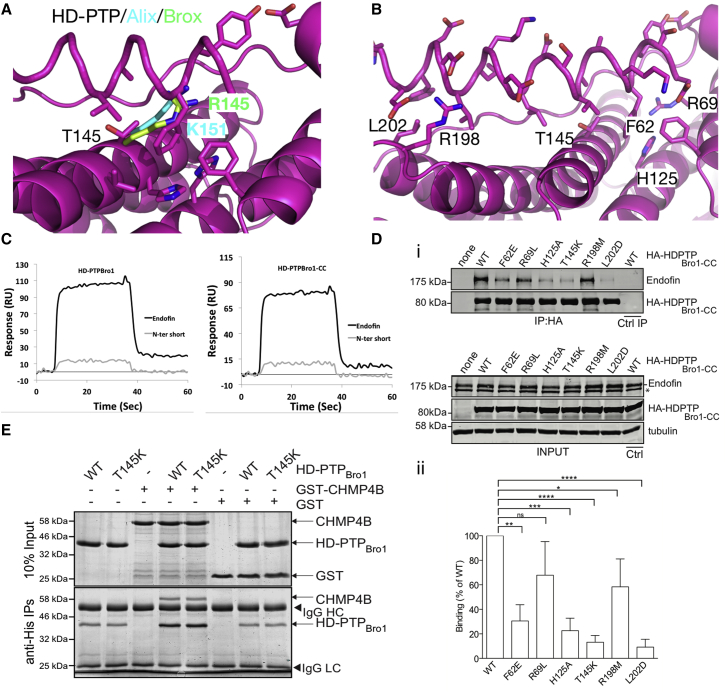
Mapping the Interface at the S Site(A) Detail at the S site of HD-PTPBro1-endofin complex showing the position of T145, a key residue at the binding interface. The cognate residues on the related Bro1 proteins (K151 in Alix in cyan; R145 in Brox in green) are larger and clearly would clash with the endofin peptide, explaining the binding selectivity observed.(B) Detail of the HD-PTPBro1-endofin binding interface showing the position of the residues used in the mutagenesis evaluation, labeled black.(C) Biosensor binding studies confirmed the importance of the conserved MXXYF region at the N terminus of the SARA and endofin peptides. An endofin peptide lacking these residues shows poor binding to HD-PTPBro1 and HD-PTPBro1-CC as shown in contrast to the wild-type endofin peptide.(D) HA-HD-PTPBro1-CC or the indicated mutants were expressed in cells and anti-HA immunoprecipitates were probed with anti-endofin antibody. Left panel shows an example experiment, representative of three independent experiments. Inputs are shown in the bottom panel and anti-HA Immunoprecipitations (IP) are shown above. The asterisk denotes a likely endofin cleavage product lacking the N terminus, or cross-reacting species recognized by the endofin antibody. The species is present in cell lysates but not in anti-HA IPs. Right panel shows quantitation from four independent experiments (mean ± SD). Statistical analysis was performed using the unpaired t test with Welch's correction: ∗∗∗∗p < 0.0001, ∗∗∗p < 0.001, ∗∗p < 0.01, ∗p < 0.05; ns, not significant.(E) Co-immunoprecipitation of bacterially expressed GST, or GST-CHMP4B combined with His-HD-PTP, shows that binding to GST-CHMP4B is not affected by mutation of T145 to K in His6-HD-PTPBro1-CC. Representative of three independent experiments.